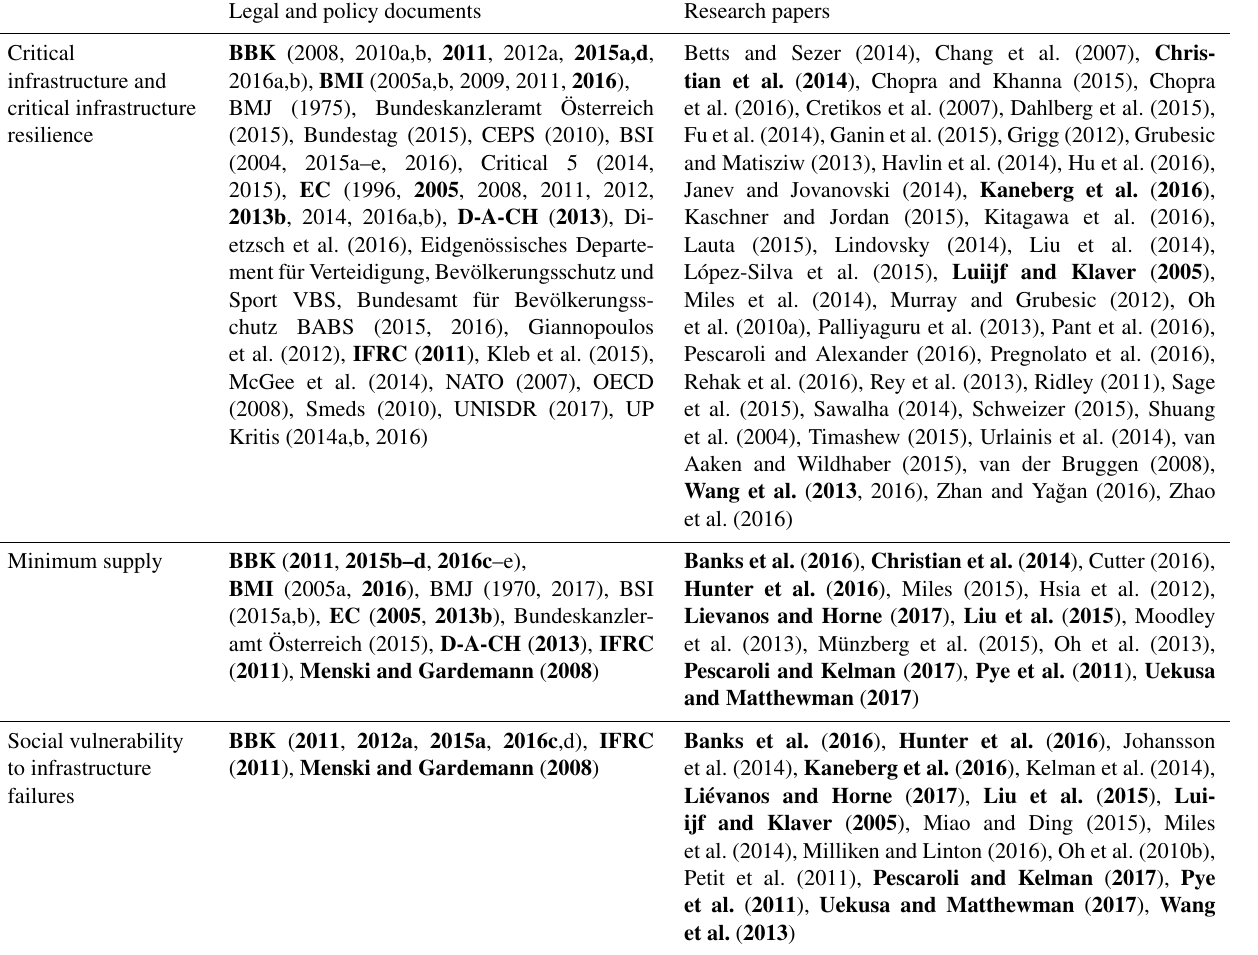
Table 1. List of key references per subcategory (few papers deal with more than one category; these papers are highlighted in bold). Legal and policy